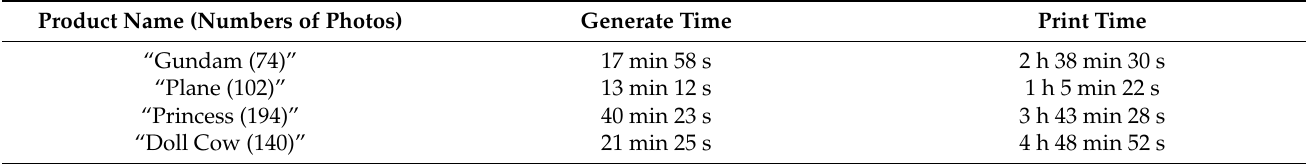
Table 3. Some examples of 3D content generation based on Surrounding photos.